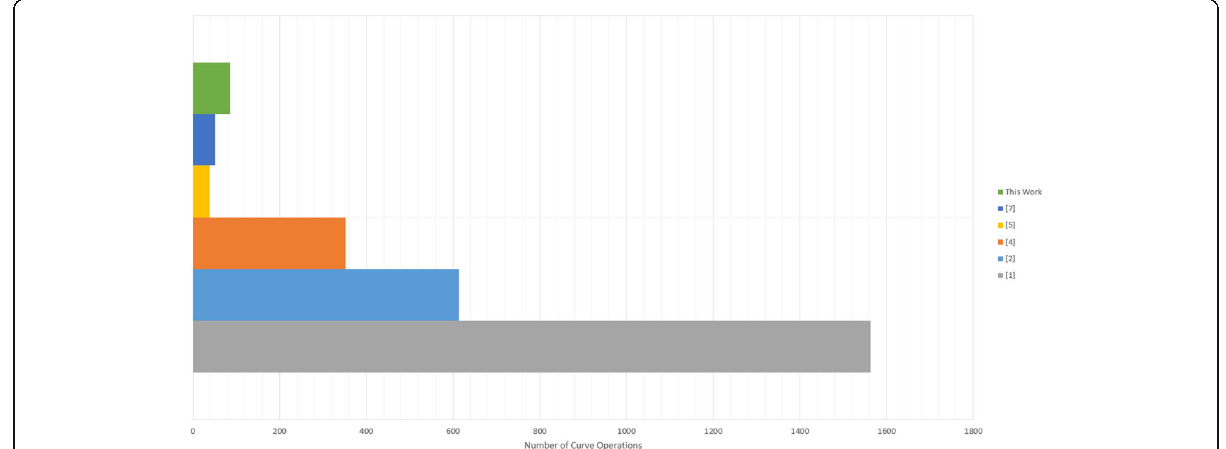
Fig. 4 Curve25519 based curve operation cost comparison of 128-bit encrypted key generation with similar existing